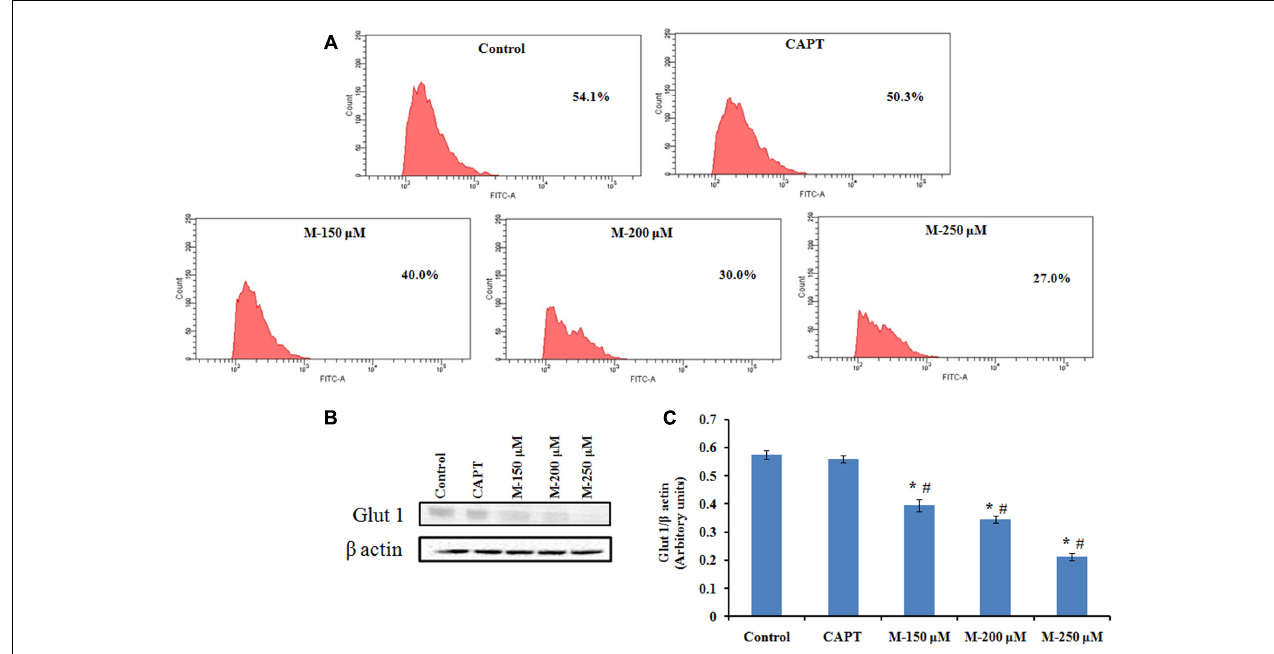
FIGURE 10 | Flow cytometry analysis of 2-NBDG uptake and western blot analysis for Glut 1 expression. SW480 cells were treated with various concentrations of morin (150, 200, and 250 µ M) and camptothecin (50 µ M) for 48 h. (A) FACS analysis of 2-NBDG uptake in SW480 cells plotting cell count against FITC. (B) Glut 1 expression analyzed by western blotting. (C) Quantification of Glut 1 protein levels. CAPT: camptothecin (50 µ M), M (150, 200, and 250 µ M): Morin (150, 200, and 250 µ M). Each value represents mean ± SD (standard deviation) from three independent experiments. Significance levels between different groups were determined by using one way ANOVA, followed by Duncan’s multiple range test. ∗ p ≤ 0.05 versus control, # p ≤ 0.05 versus